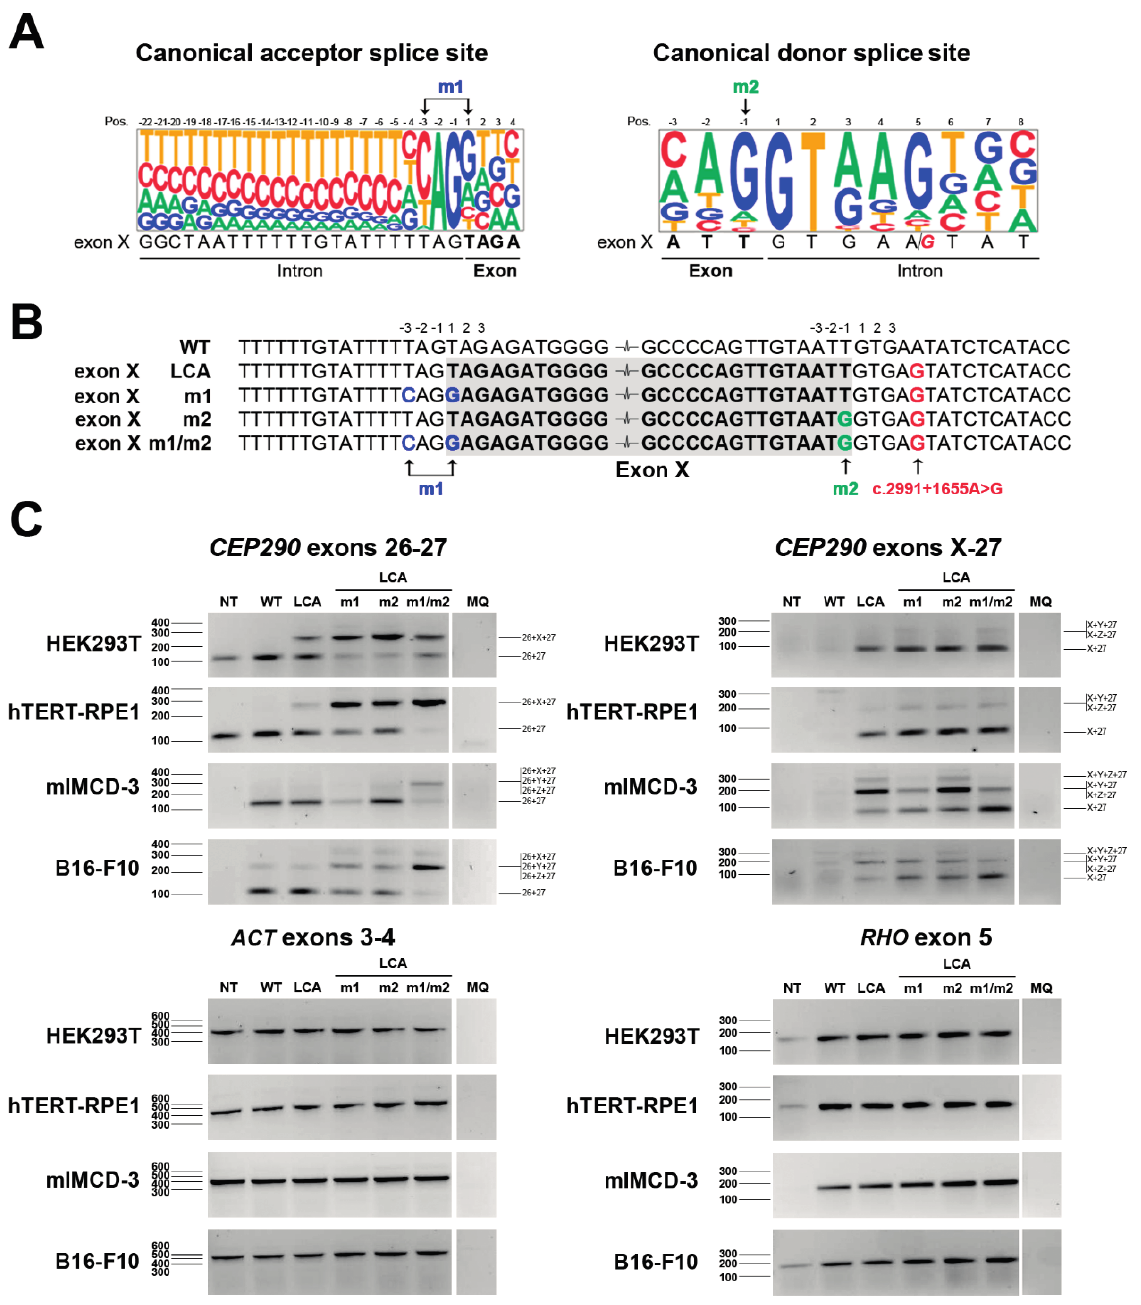
Figure 2. Evaluation of the modification of the splice sites of exon X. ( A ) Sequence alignment of the splice site sequences of exon X with the consensus canonical acceptor and donor splice sites; ( B ) Representation of the sequences surrounding exon X and the mutations introduces (m1: blue; m2: green; c.2991+1655A>G in red) in all the constructs generated; ( C ) Evaluation of the splicing pattern observed in these constructs after overexpression in two human (HEK293T and hTERT-RPE1) and two murine (mIMCD-3 and B16-F10) cell lines. Amplification of actin ( ACT ) and rhodopsin ( RHO ) was used for normalization and to assess transfection efficiency, respectively. Milli-Q water (MQ) was used as negative control of the PCR. Semiquantitative analysis of the gels is shown in Supplementary Figure